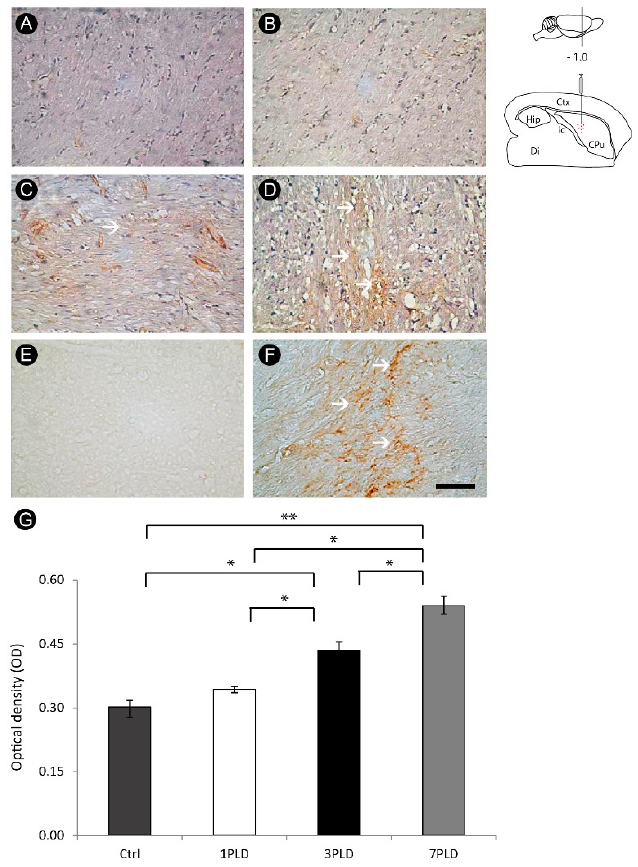
Figure 8. Axonal lesion in the internal capsule following endothelin-1 (ET-1) striatal injection. Control ( A ) and ET-1-injected groups at 1PLD ( B ), 3PLD ( C ) and 7PLD ( D ). The peak of APP labeling is observed at 7PLD, evidenced by a diffuse axon labeling (arrows in ( D )). Caspase-3 immunohistochemistry allowing identifying a similar pattern of immunoreactivity, with intense labeling at 7PLD ( F ) (arrows). Control group presenting the absence of caspase-3 labeling ( E ). Progressive APP labeling across time points was confirmed by densitometric analysis ( G ) (* p < 0.05; ** p < 0.01, ANOVA, Tukey post hoc test). Drawings at the left side of the figure show the anatomical localization of the ET-1 injection in the striatum. Ctx: cortex; CPu: caudate putamen (striatum); Di: diencephalon; Hip: hippocampus; ic: internal capsule. Scale bar: 50 μ m.